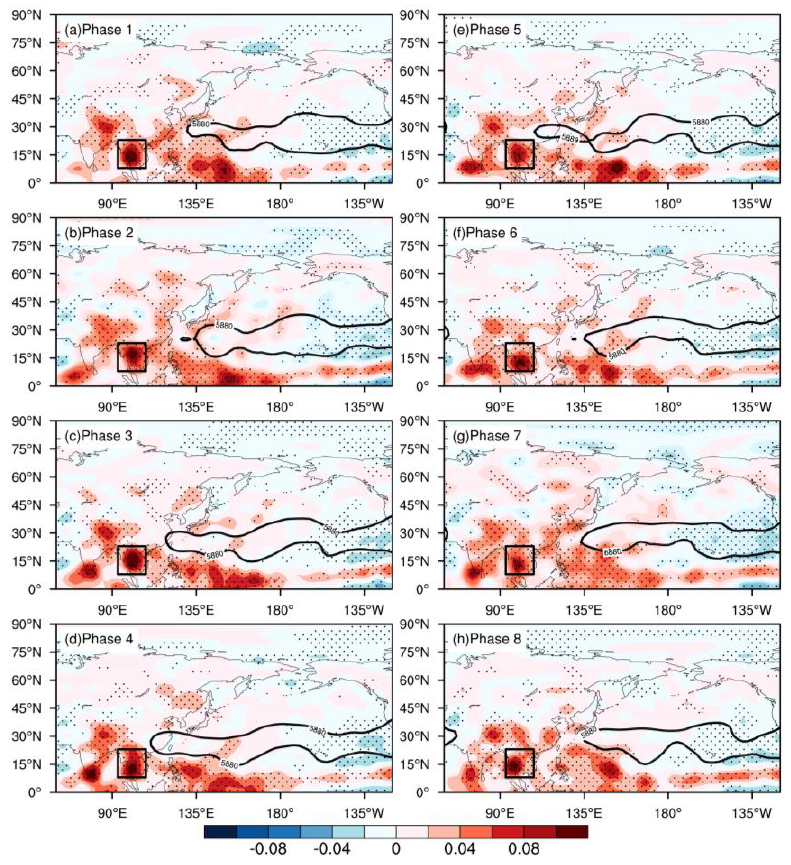
Figure 3. Temporal evolution of ( a – h ) 500 hPa original apparent heat source Q 1 field (shading; units: W/kg). The area shown in the black box is (8° – 23° N, 93° – 108° E), black contours in the panel are 500 hPa geopotential height by 5880 gpm that represent the WPSH location. Black dots represent values exceeding the 90% confidence level.